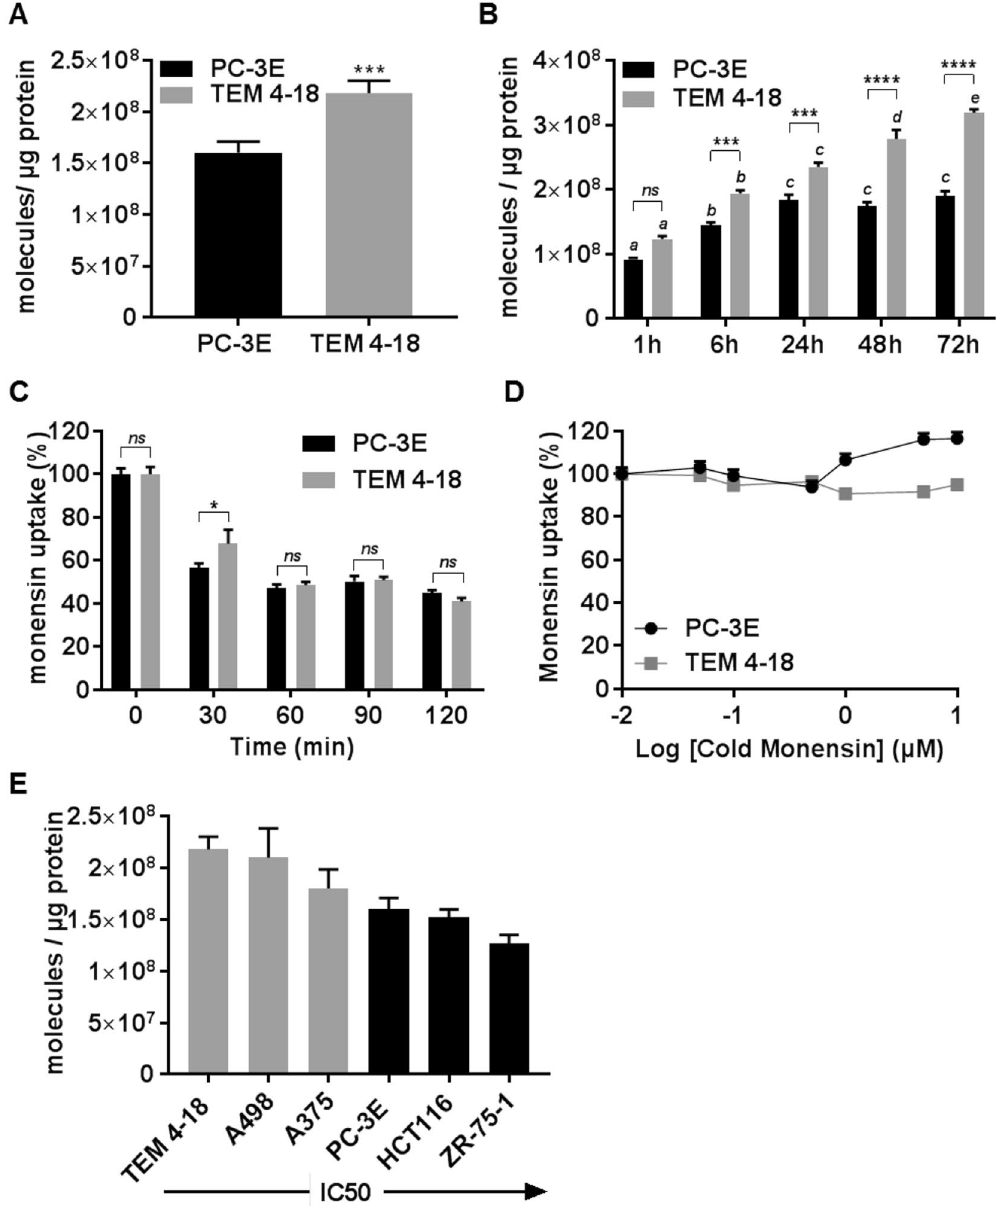
Figure 7. Monensin sensitivity is correlated with increased cellular uptake in EMT-like cells. Cellular uptake of 3 H-monensin in cells treated with 3 H-monensin (10 nM) for ( A , E ) 6 h or ( B ) 1 h to 72 h. ( C ) Cells were treated with 3 H-monensin (10 nM) for 6 h. Cellular monensin retention was measured 0, 30, 60, 90 and 120 min after the media was replaced. ( D ) Cells were incubated 6 h with 3 H-monensin (10 nM) in presence of increasing concentration of cold monensin. Results were expressed in percentage of the radioactivity measured in cells treated with 3 H-monensin only. Data represent mean values ± SEM of at least 3 independent experiments. * p < 0.05, ** p < 0.01, *** p < 0.005, **** p < 0.0001. Different letters on top of bars indicate significant differences among time points ( p < 0.05) (n ≥